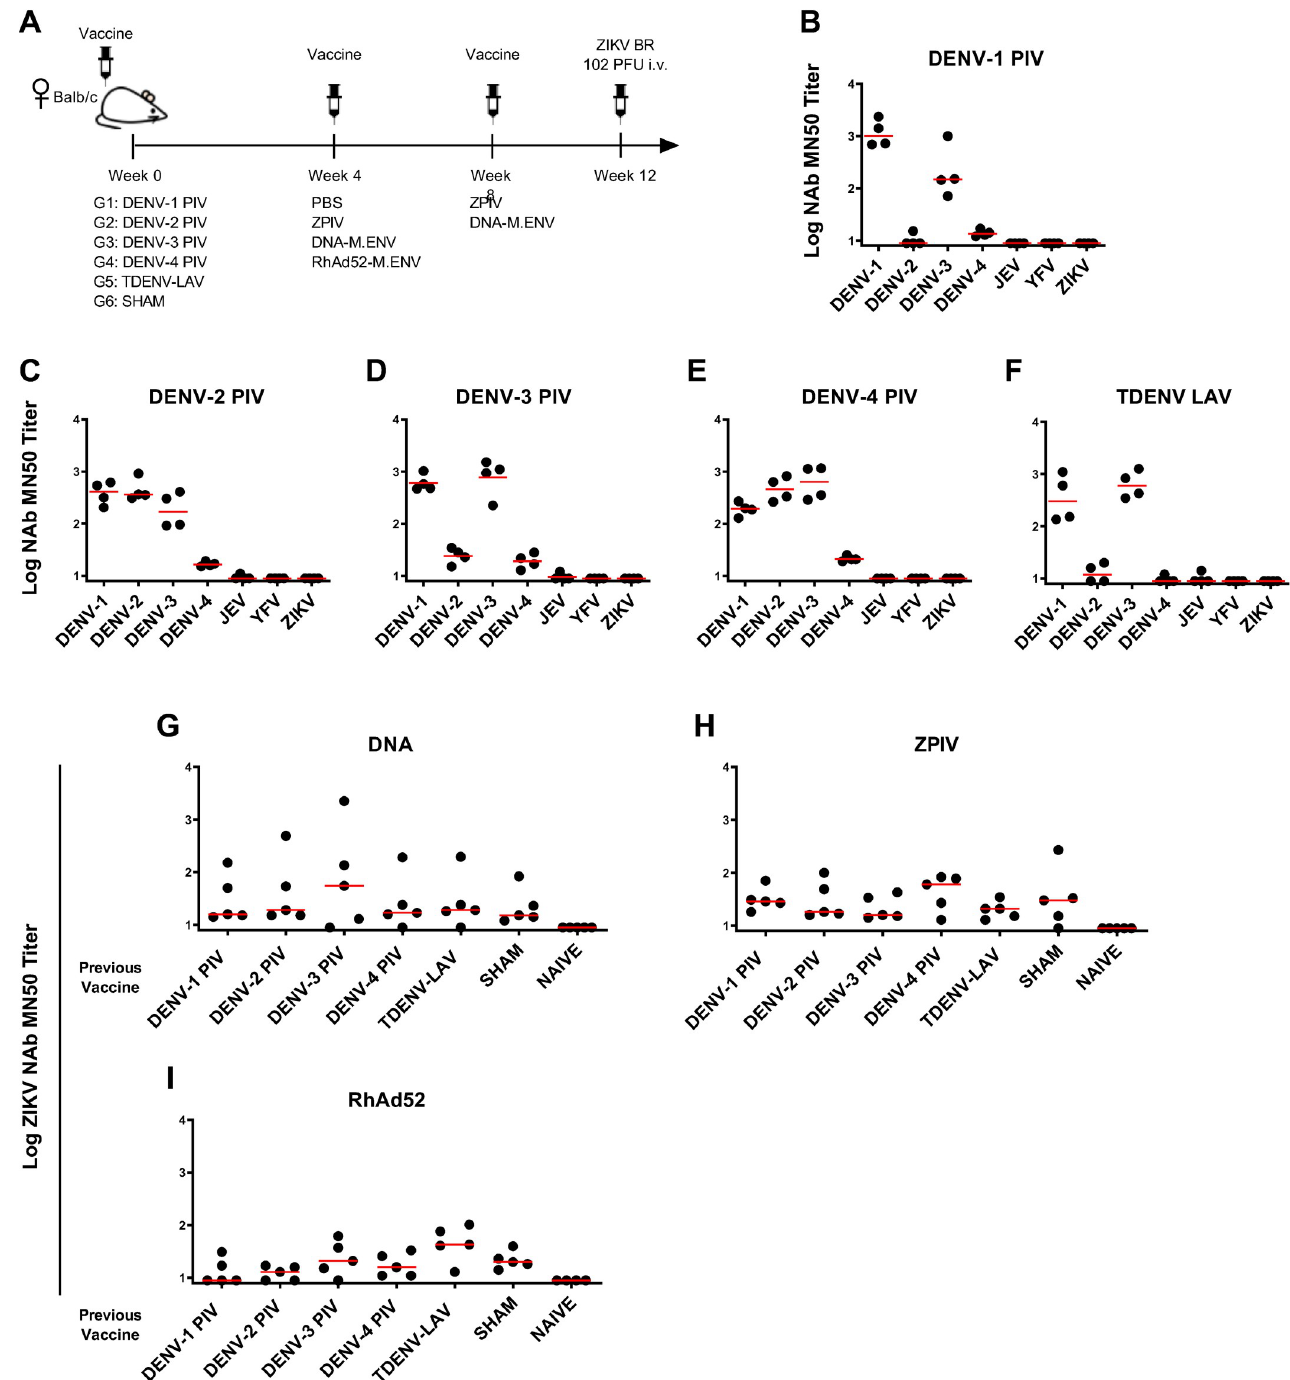
Fig 3. Induction of Neutralizing antibodies by TDENV-LAV, DENV-PIV and ZPIV vaccines. (A) Study Schematic Design. Mice (n = 5 mice per group) were immunized intramuscularly (i.m.) on weeks 0 with 1 μ g of each DENV serotype of the purified inactivated vaccine (DENV-PIV) or 10 2 PFU of the live attenuated tetravalent DENV vaccine (TDENV-LAV) and vaccinated on weeks 4 and 8 with 50 μ g of the DNA-M.ENV vaccine and 1 μ g of the purified inactivated ZIKV (ZPIV). Mice received a single immunization with 10 9 vp of the RhAd52-M.ENV vaccine. Mice were challenged i.v. with 10 2 PFU ZIKV-BR 4 weeks after DNA-M.ENV and ZPIV vaccination and 8 weeks after RhAd52-M.ENV vaccination. (B-F) Log MN50 titers against DENV serotypes 1–4, JEV, YFV and ZIKV induced by each DENV-PIV vaccine. (B) DENV-1, (C) DENV-2, (D) DENV-3, (E) DENV-4, and (F) TDENV-LAV. (G-I) Log anti-ZIKV MN50 titers in mice previously exposed or not to DENV vaccines in (G) DNA-M.ENV, (H) ZPIV, and (I) RhAd52-M.ENV vaccinated mice. Data is representative of one experiment with 4–5 animals per group. Each dot represents an individual mouse.